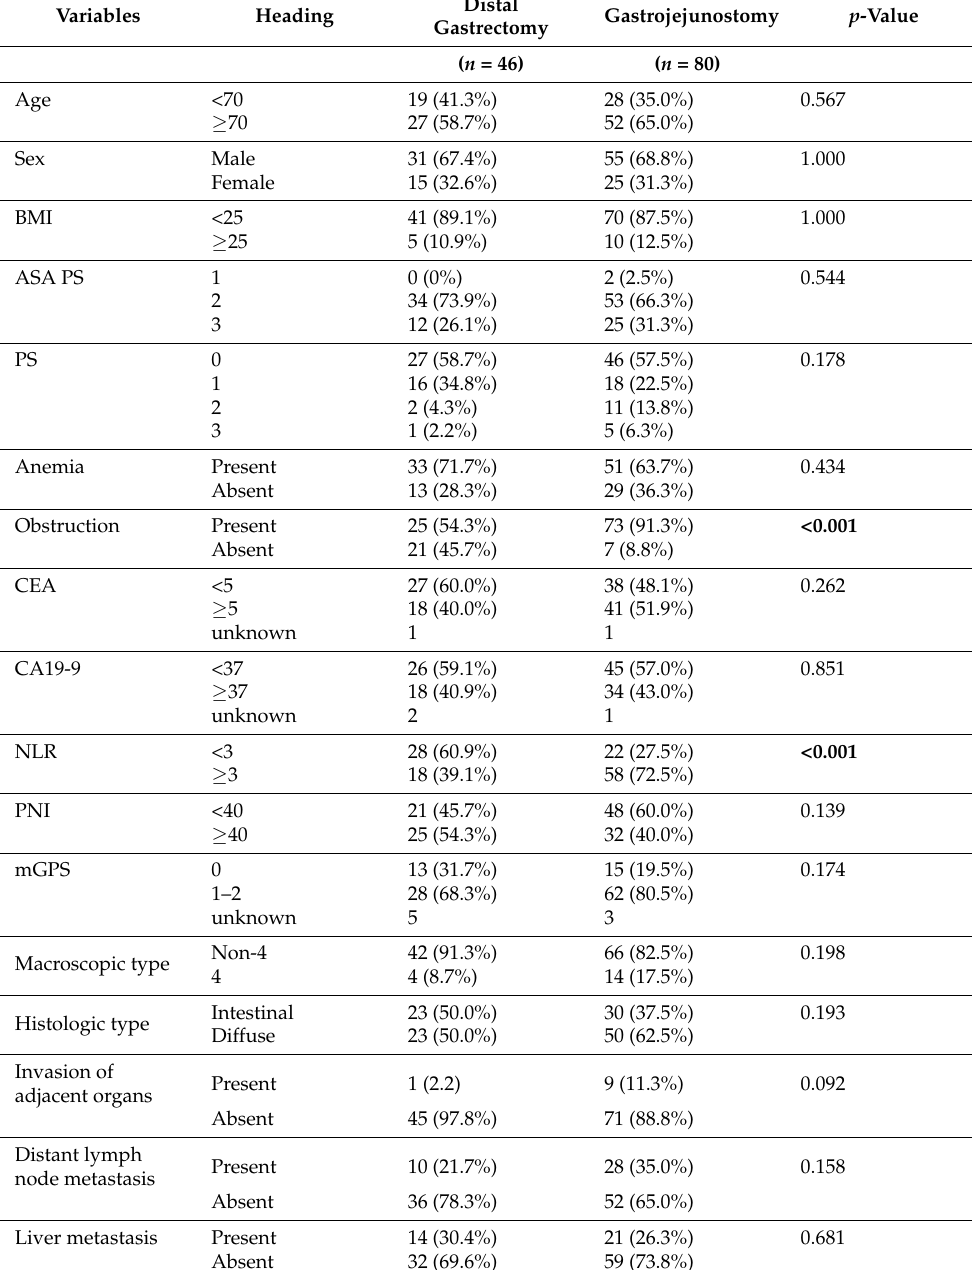
Table 1. General characteristics of 126 GC